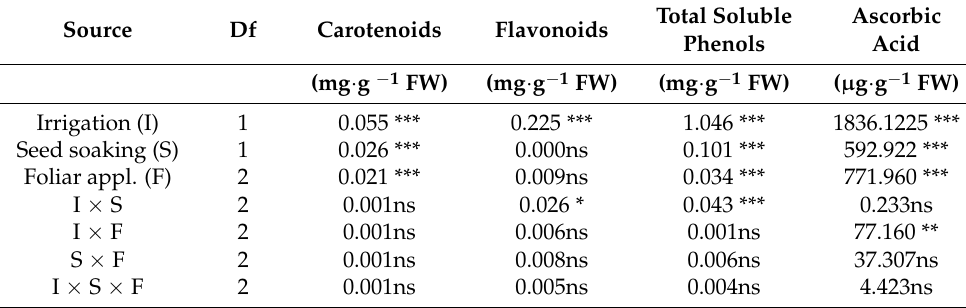
Table 4. Analysis of variance (mean square) of non-enzymatic antioxidants.